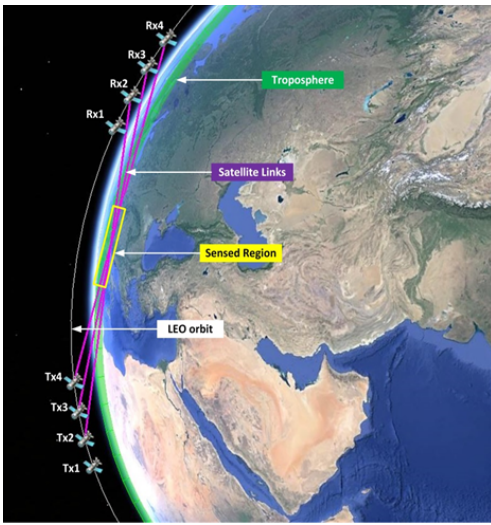
Figure 1. Acquisition scheme of the NDSA measurements of IWV for a constellation system of co-rotating LEO